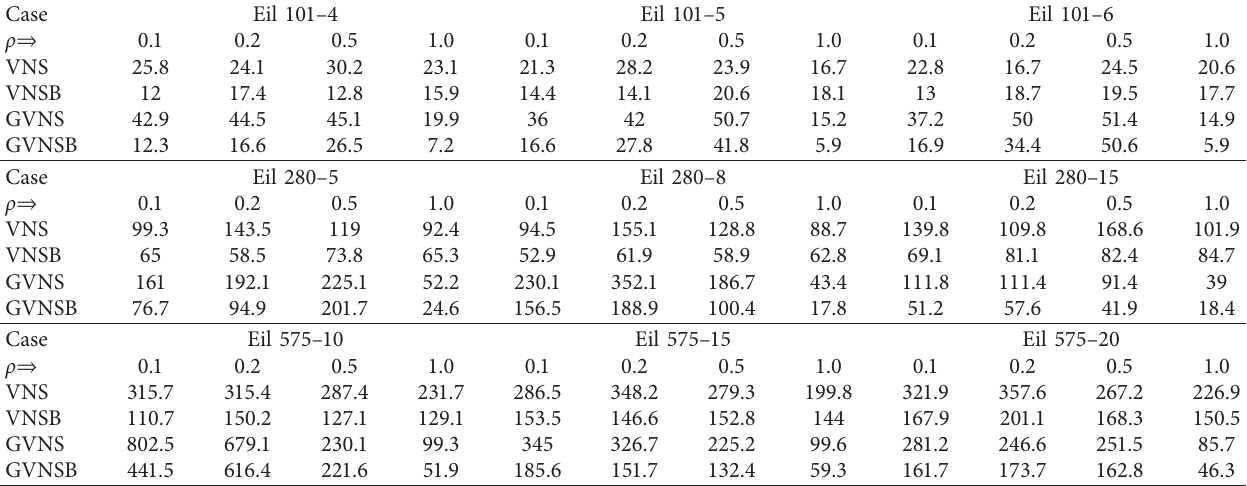
Table 3: The standard deviations of VNS, VNSB, GVNS, and GVNSB in environment τ � 50. Case